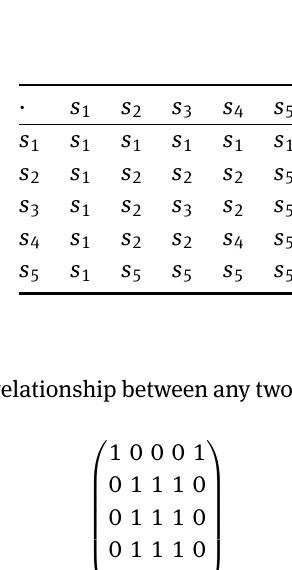
Table 2: The multiplication table on